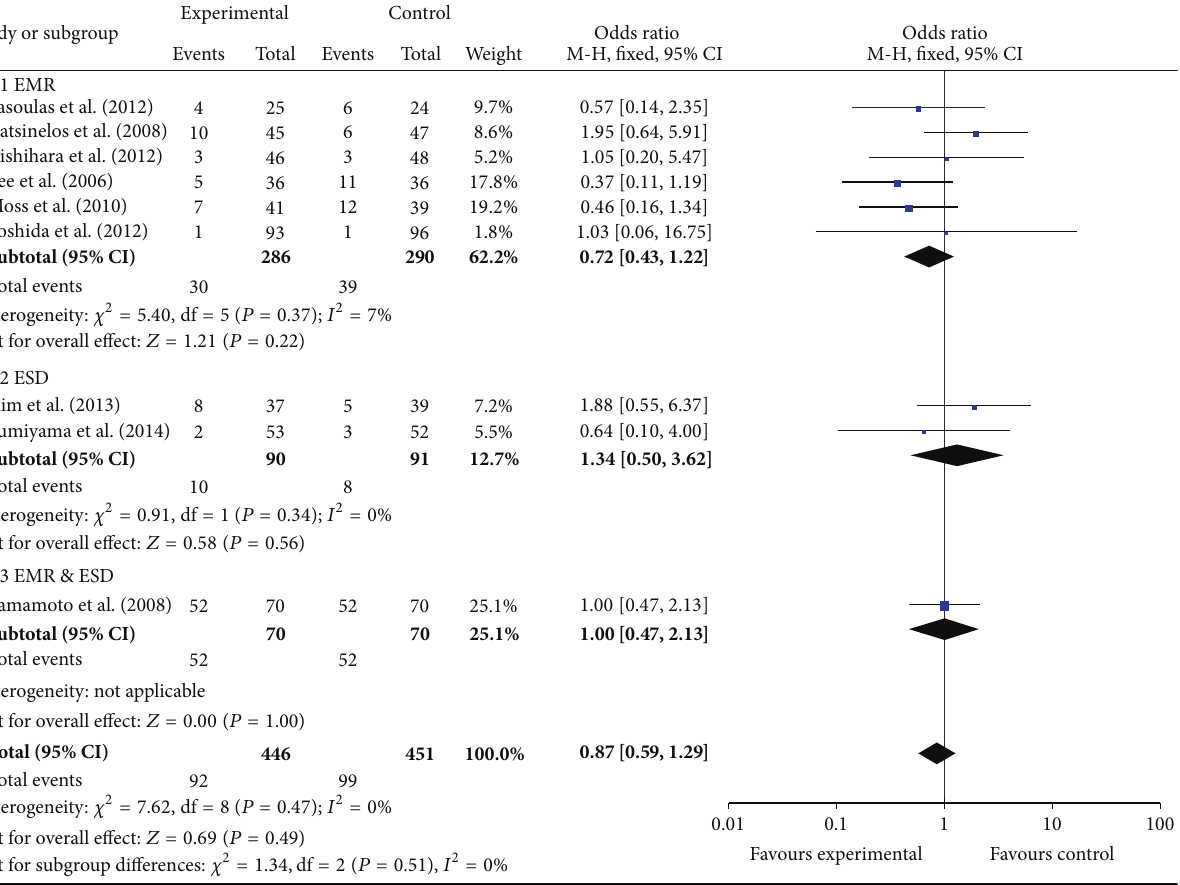
Figure 5: Subgroup meta-analysis of total